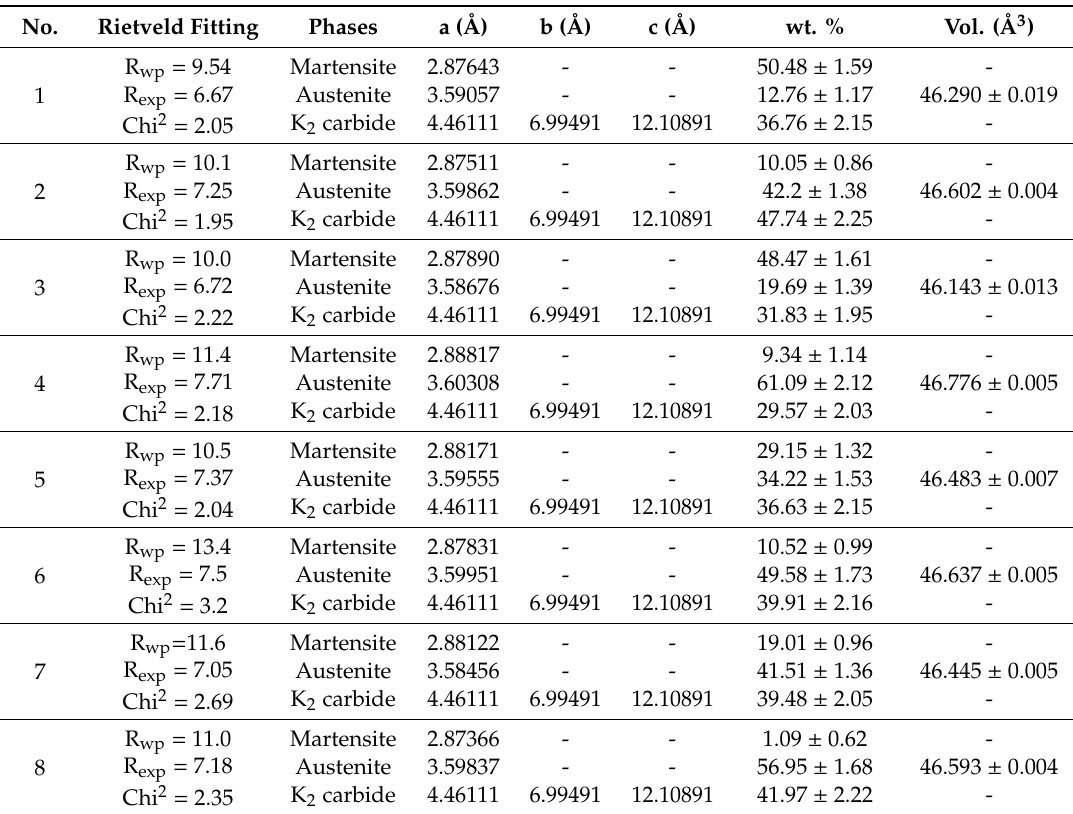
Table 5. Microstructural parameters, weight distributions of the precipitated phases and volume of